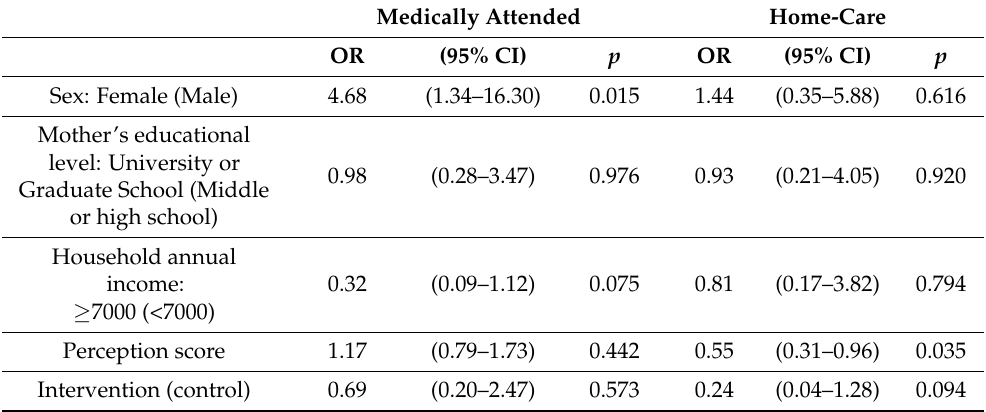
Table 4. Injury risk